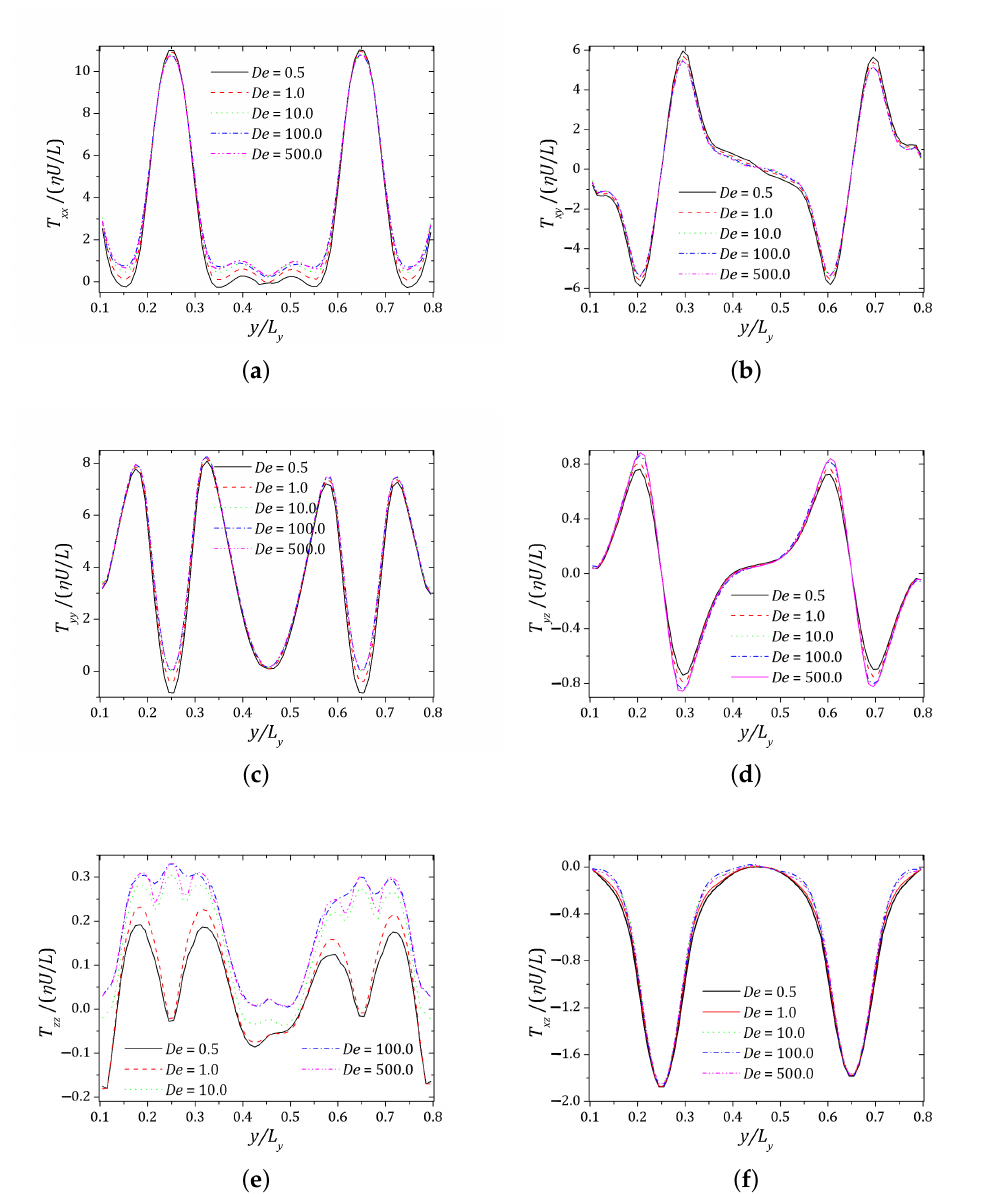
Figure 12. Tensor components: ( a ) T xx ; ( b ) T xy ; ( c ) T yy ; ( d ) T yz ; ( e ) T zz ; ( f ) T xz